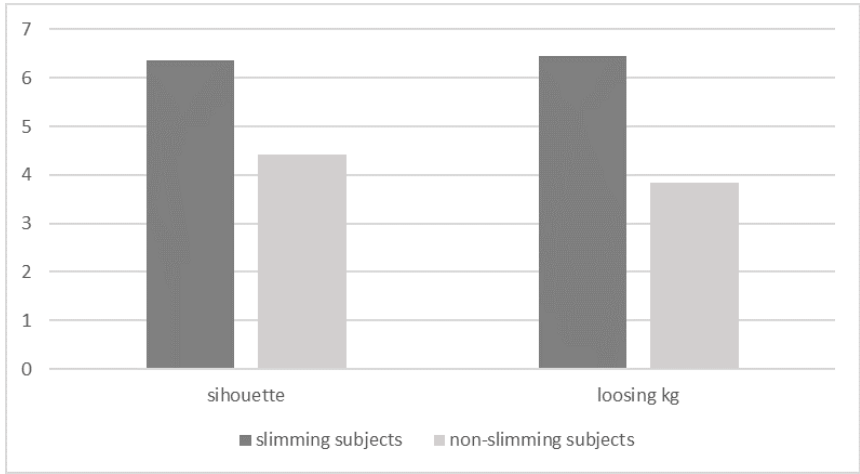
Figure 1. The importance of dietary goals as a result of priming among sliming vs. non-slimming subjects.